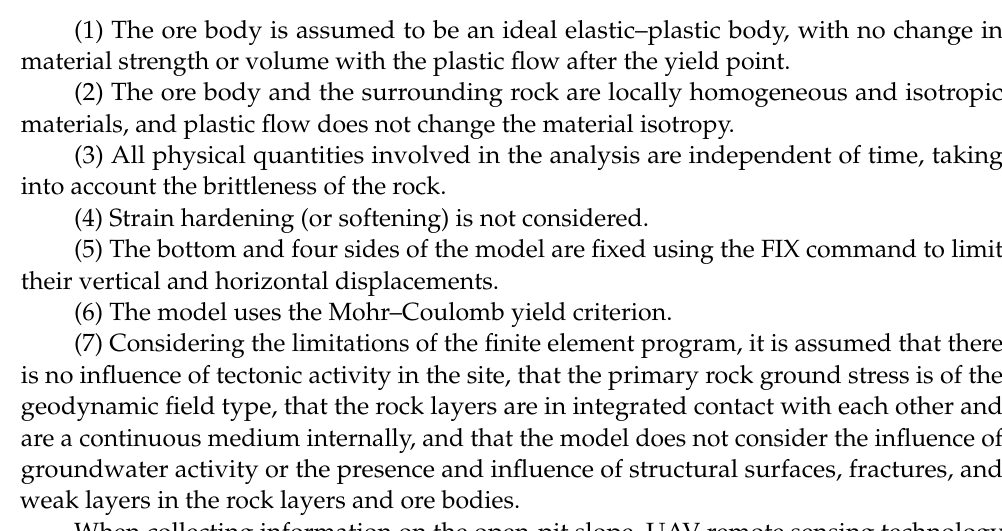
Figure 6. Top view of the established 3D model.